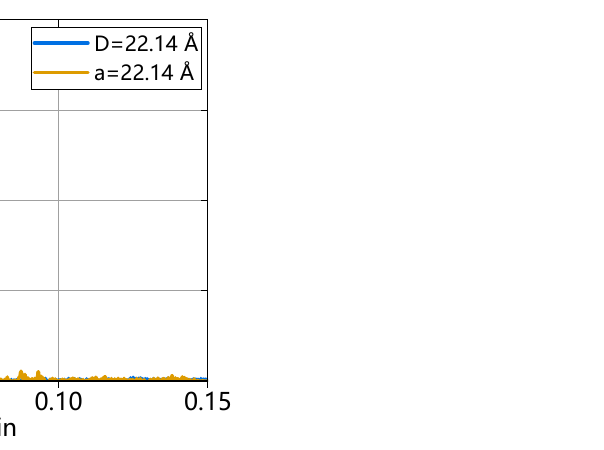
Figure 8. Comparison of stress–strain curves between circular cracks and regular quasi-hexagonal cracks. Table 2. Circular crack.